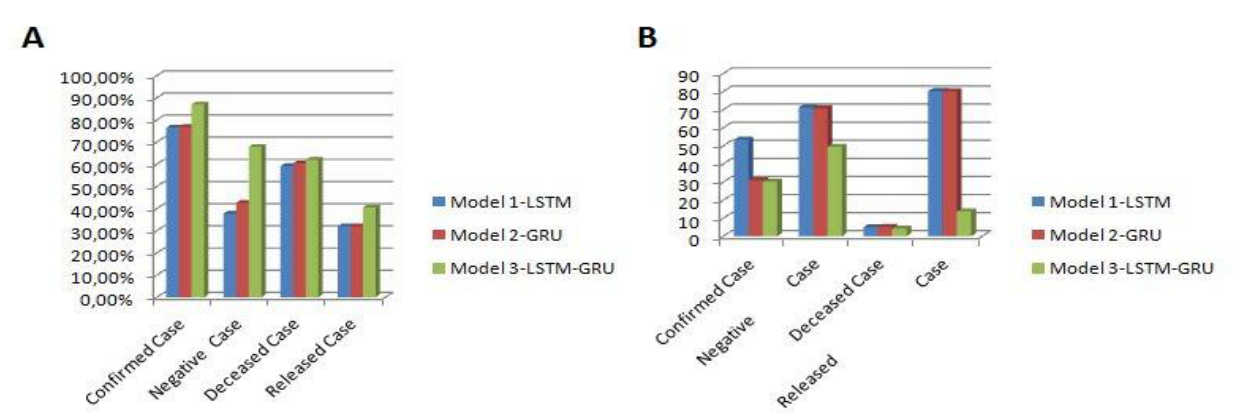
model combines LSTM and GRU RNN shows best performance. Figure 6 depict the plotting of real result and predicted result for all the cases obtained for LSTM-GRU RNN.